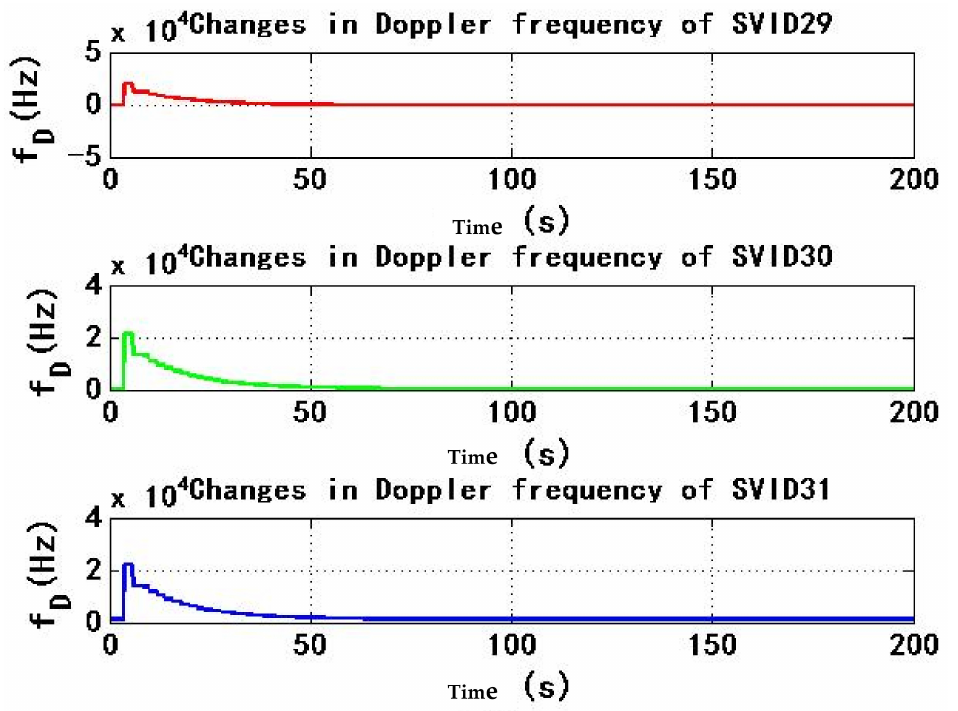
Figure 14. Changes in Doppler frequency of SVID29, 30, 31 in experiment 2.